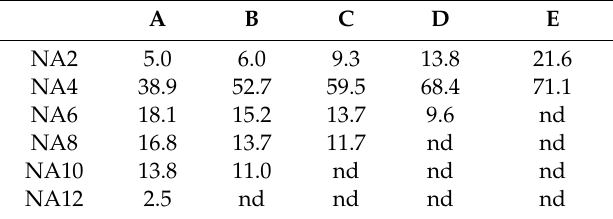
Table 2. The percentage of monomers at different hydrolysis times (mg/100mg).